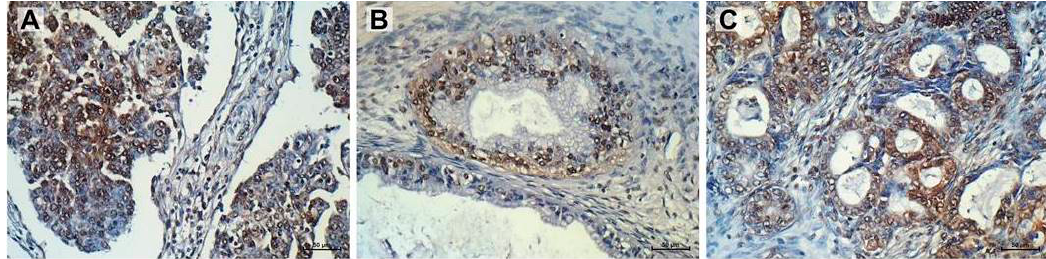
Figure 6. Immunohistochemical expression of PTPRK in serous adenocarcinoma (strong nuclear, moderate / weak cytoplasmic intensity score) ( A ); mucinous ovarian cancer (strong nuclear, moderate cytoplasmic intensity score) ( B ); and endometrioid adenocarcinoma (weak nuclear, strong cytoplasmic intensity score) ( C ). Sections were counterstained with hematoxylin. Scale bar = 50 µm.